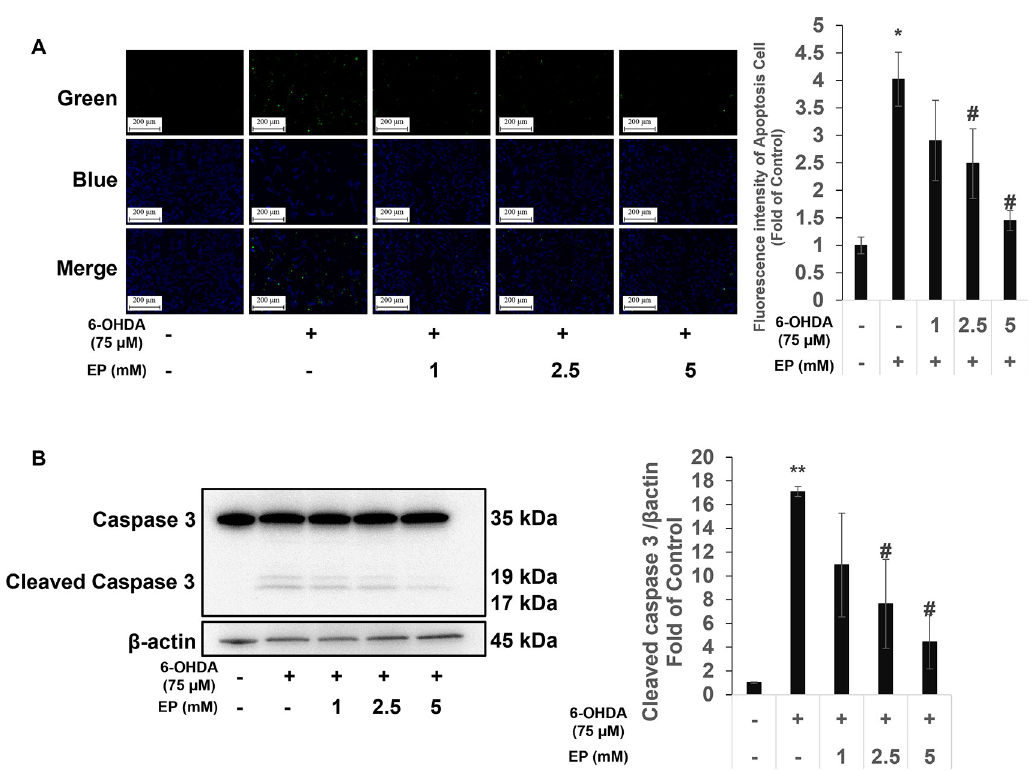
Fig 2. Effects of EP on 6-OHDA induced cell death. (a) Apoptotic or necrotic (green), and live (blue) cells visualized using fluorescence microscopy. (b) Representative western blots of caspase-3 and cleaved caspase-3 (c) quantified using ImageJ. Results are expressed as means ± standard deviation (N � 3. � P < 0.01 vs . control; † P < 0.05 vs . 6-OHDA. Scale bars, 200 μ m.